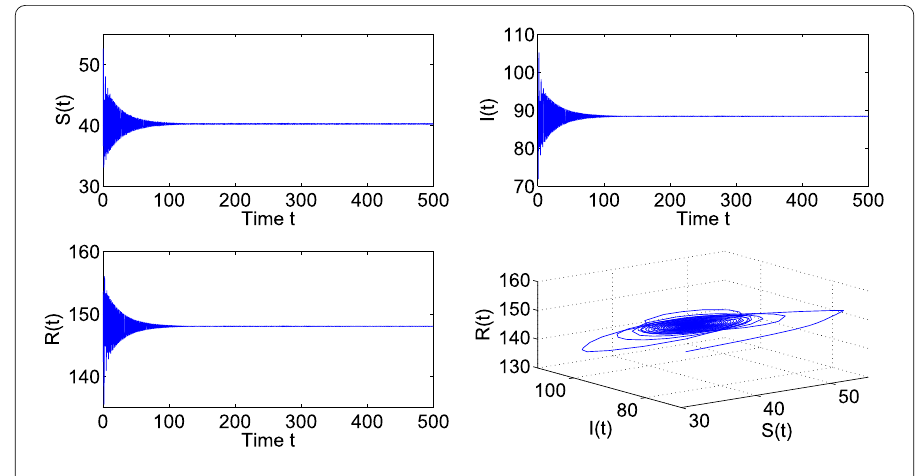
Figure 6 E ∗ is locally asymptotically stable when τ = 0.825 < τ 0 = 0.8805